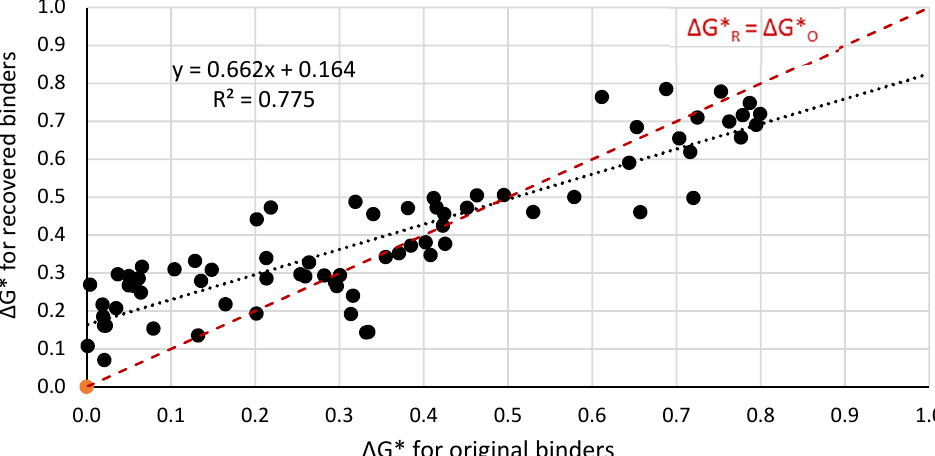
Figure 5. Correlation of the Δ G* R index for extracted binders and Δ G* O index for original binders in the temperature range from − 5 °C to +100 °C in the group of all bitumens.